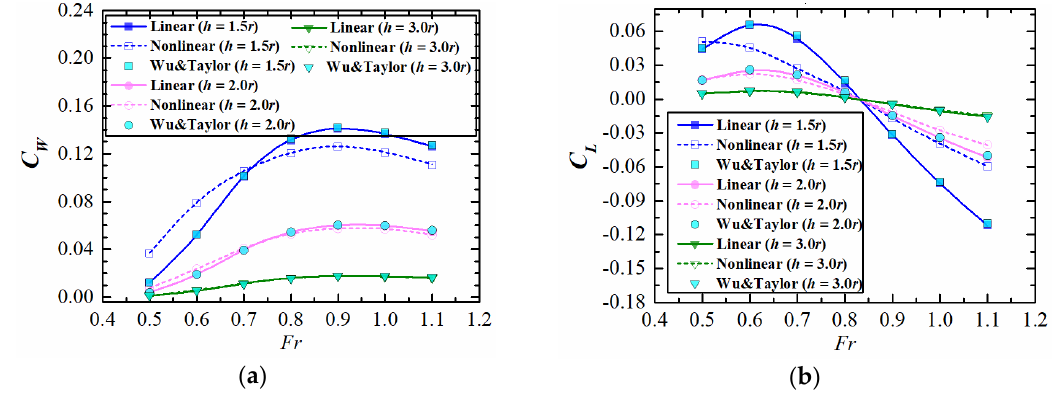
Figure 4. Coe ffi cients of wave-making resistance ( a ) and lift force ( b ) at di ff erent Fr Figure 4. Coefficients of wave-making resistance ( a ) and lift force ( b ) at different Fr .